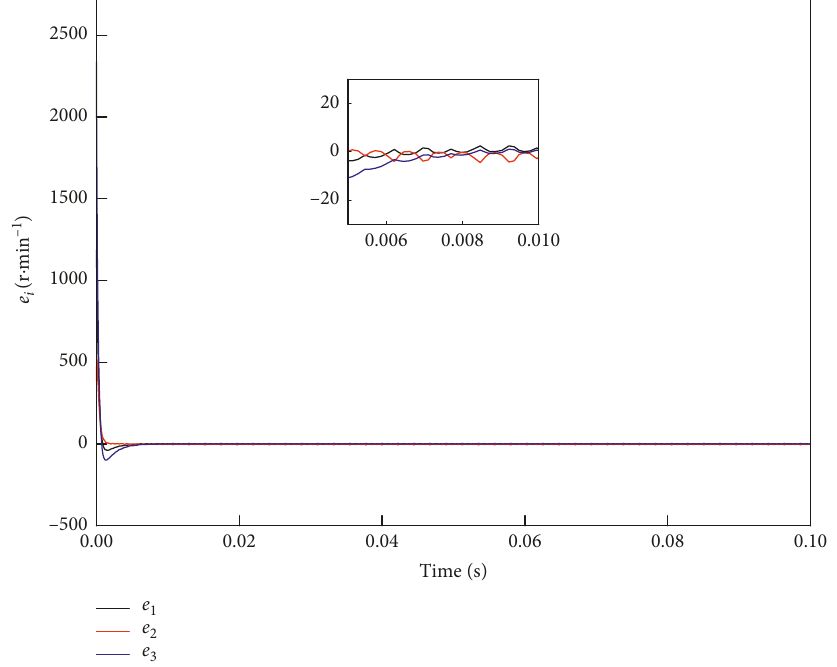
Figure 10: The error curves of the single axis system under the traditional PI